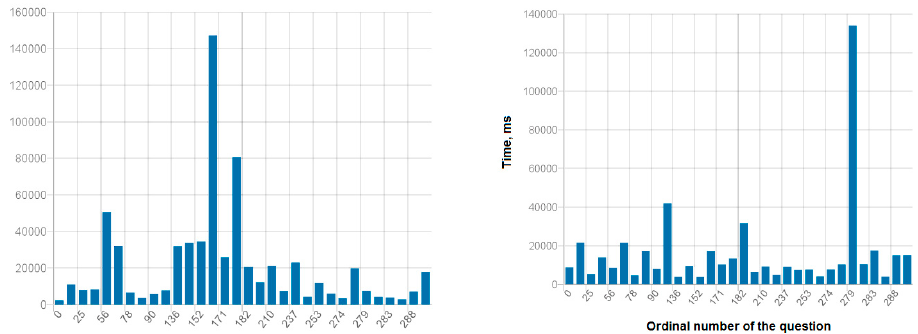
Figure 4. Reaction time of particular respondents to the questions with the delay due to possible distraction.